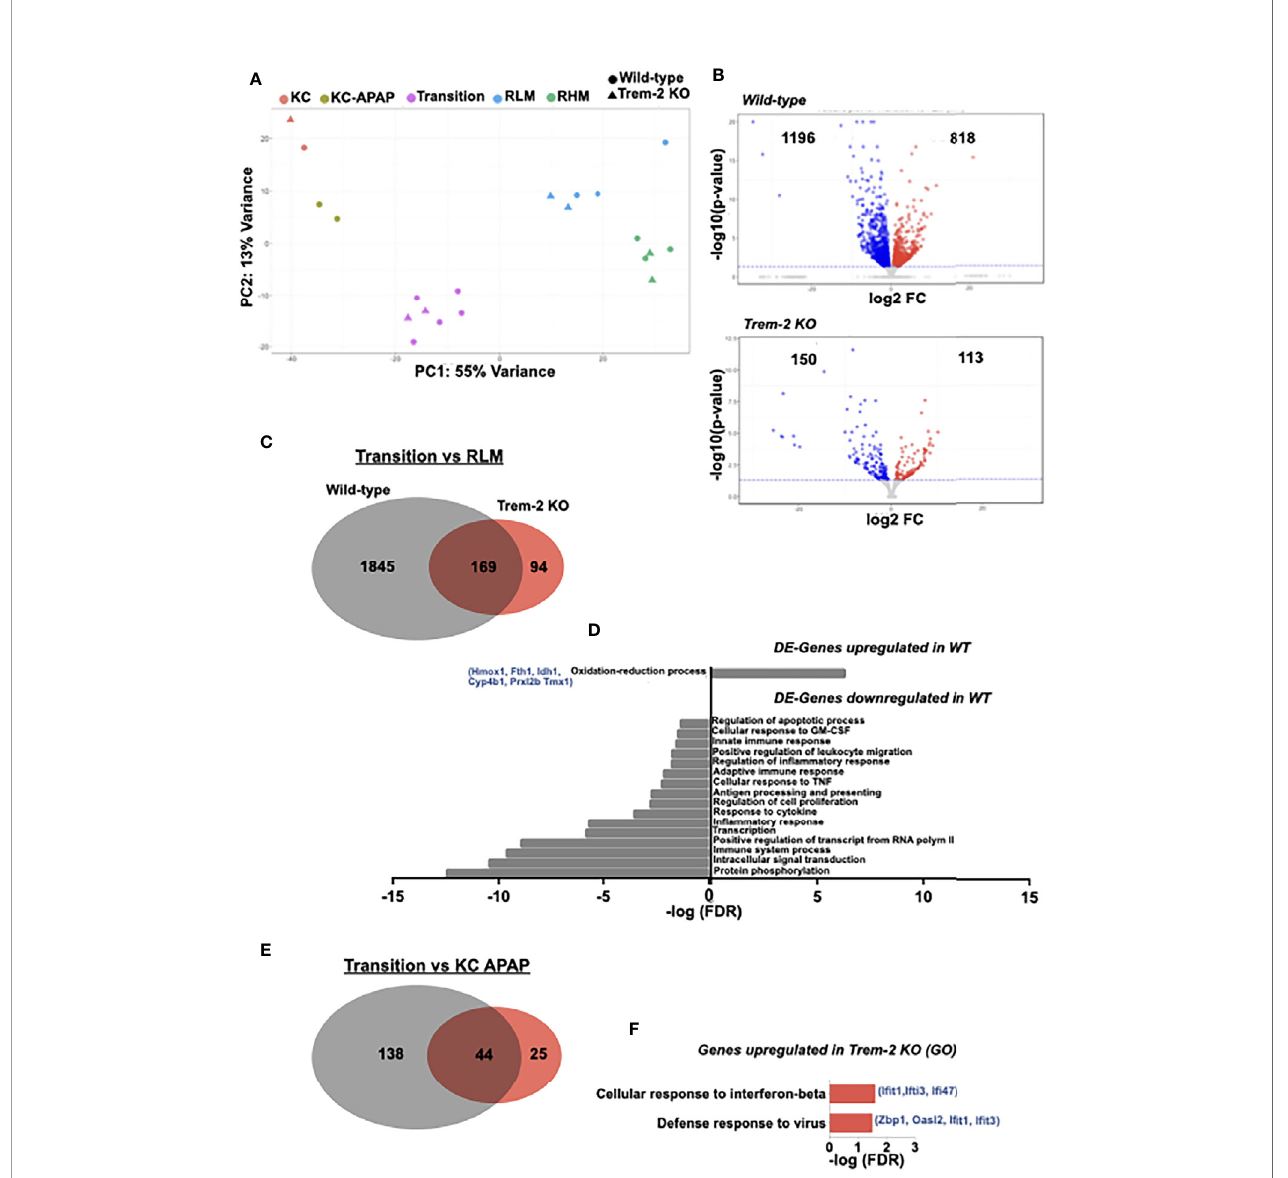
FIGURE 5 | Transcriptomic pro fi ling identi fi es a Trem-2 dependent program in transition macrophages. Principal component analysis (PCA) of transcriptomic data representing clustering of different sort-puri fi ed macrophage populations (represented by colors) from wild-type (circles) and Trem-2 KO mice (triangles) (A) . Volcano plots representing differential expressed (DE) genes (q<0.05) between transition and recruited-like macrophages (RLM) in wild-type and Trem-2 KO mice. Red dots represent upregulated genes (LogFC>0), while blue dots represent downregulated genes (LogFC<0) (B) . Venn diagram representing DE-genes between transition and RLM, which are common to wild-type and Trem-2 KO mice (middle), exclusively detected in wild-type (left) or in Trem-2 KO (right) (C) . Gene Ontology (GO) enrichment analysis in the “ Biological Process ” category for DE-genes upregulated or downregulated in transition versus RLM in wild-type mice (D) . Venn diagram representing DE-genes upregulated in transition macrophages versus Kupffer cells (KC APAP-D3) in wild-type and Trem-2 KO mice (E) . Gene Ontology (GO) enrichment analysis in the “ Biological Process ” category for DE-genes exclusively upregulated in transition macrophages of Trem-2 KO mice (F) . GO terms over- represented for FDR